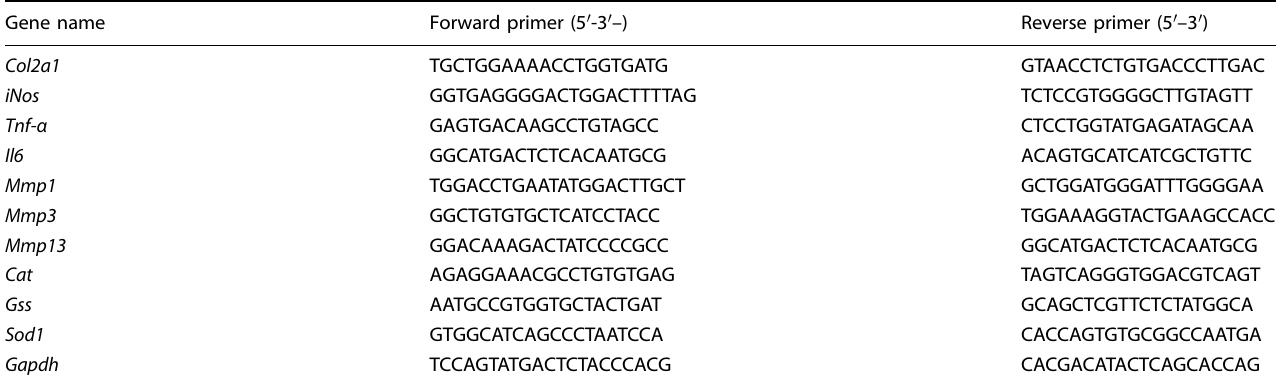
Table 2. Primer sequences used in